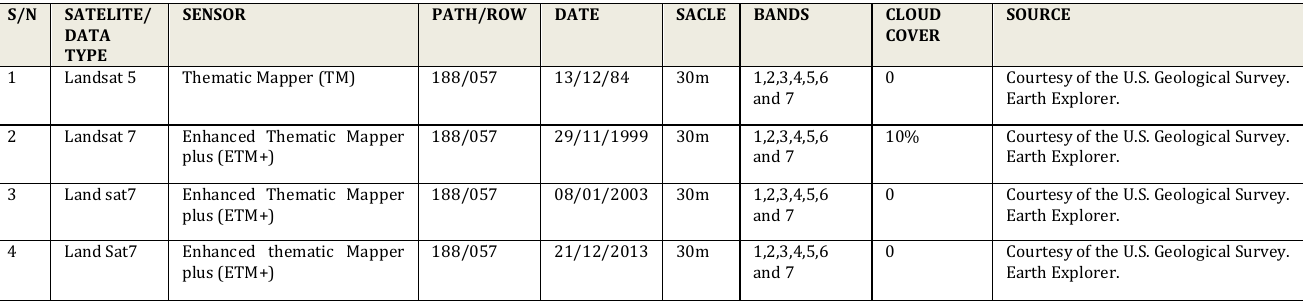
Table 1: Data Source (Source: USGS, 2014)